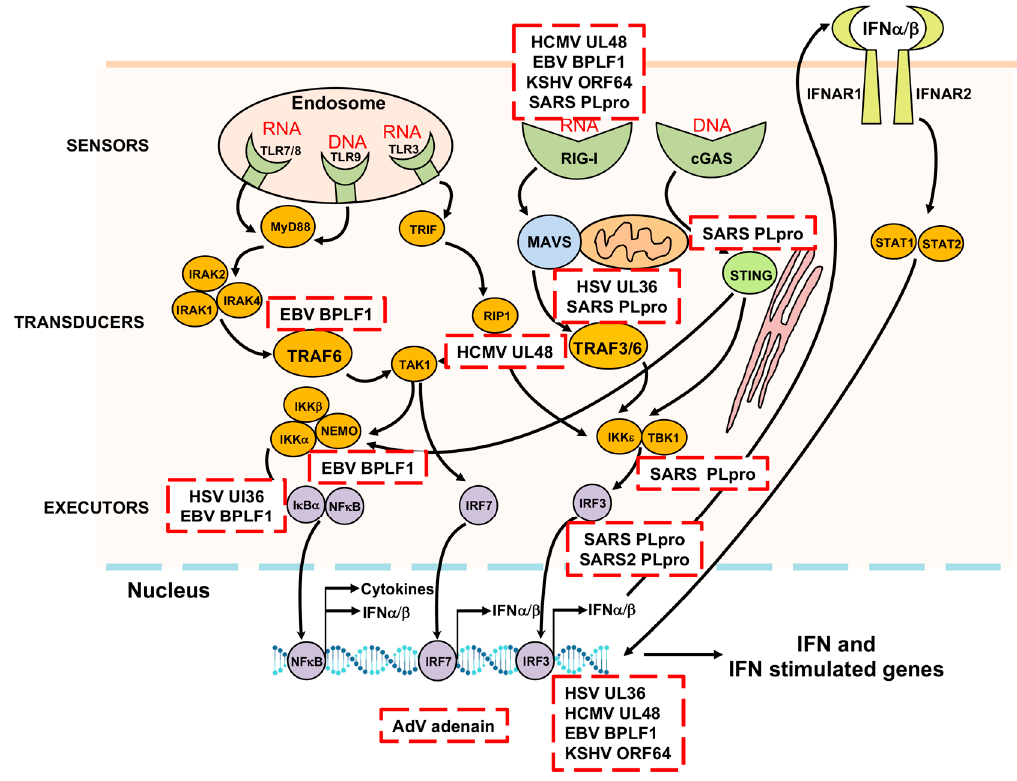
Figure 4. Cellular targets of viral UbL deconjugases. Viral UbL deconjugases target different steps of the innate antiviral response, ultimately leading to inactivation of the NF- κ B, IRF3 and IRF7 transcription factors and inhibition of the production of inflammatory cytokines and type I IFNs. In addition, nuclear targets of the deconjugases encoded by DNA viruses regulate viral DNA replication and activation of the DNA damage response.